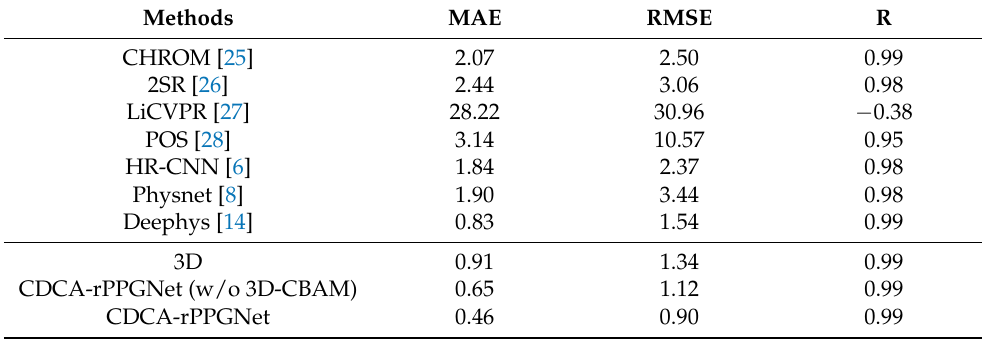
Table 2. HR Estimation Results on the PURE dataset.